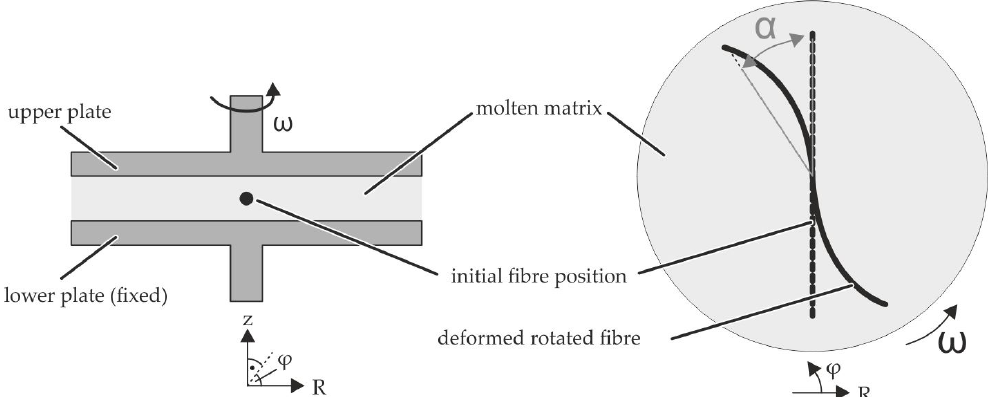
Figure 3. Principle of the parallel-plate rheometer test setup for single fibres in transverse shear flows.